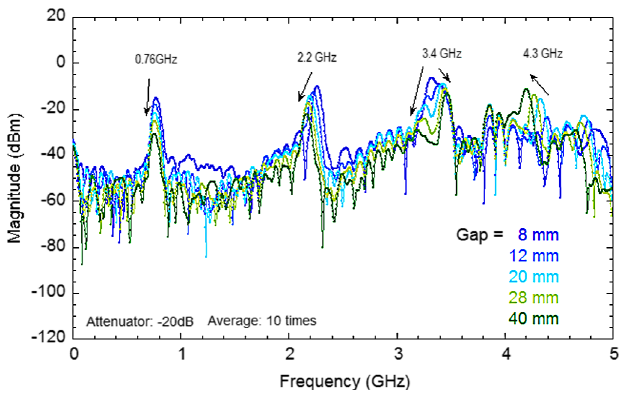
FIG. 8. Pulse shape of the beam halo monitor (blue line: one- shot measurement; red line: 10-shot average).